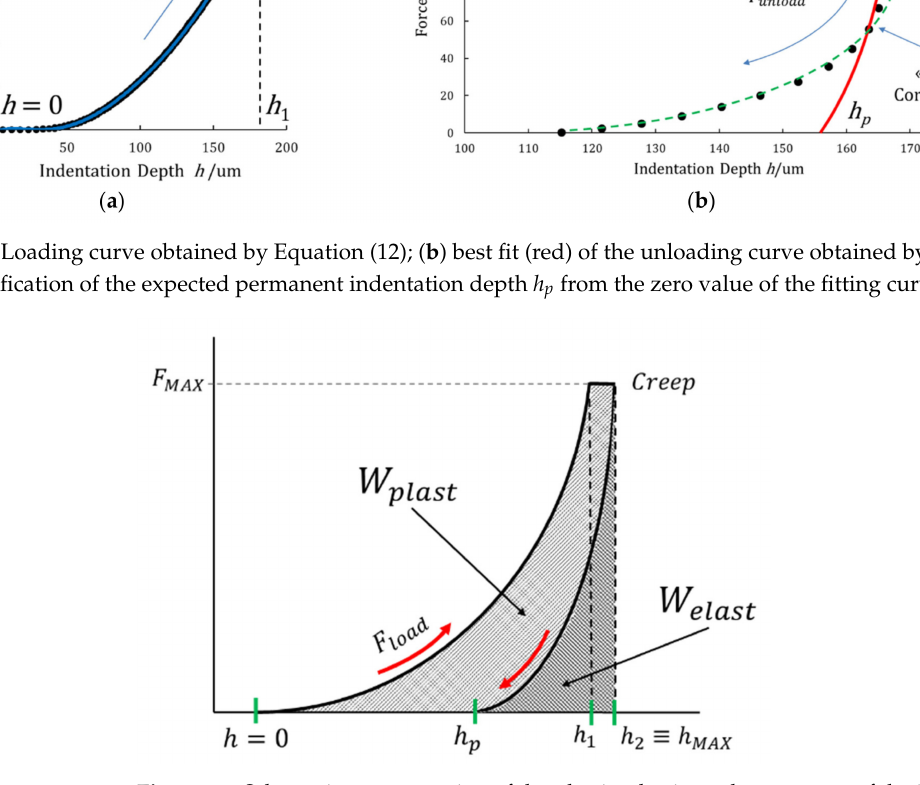
Figure 12. Schematic representation of the plastic, elastic, and creep parts of the indentation work be- neath the loading and unloading indentation curves as a function of applied force and